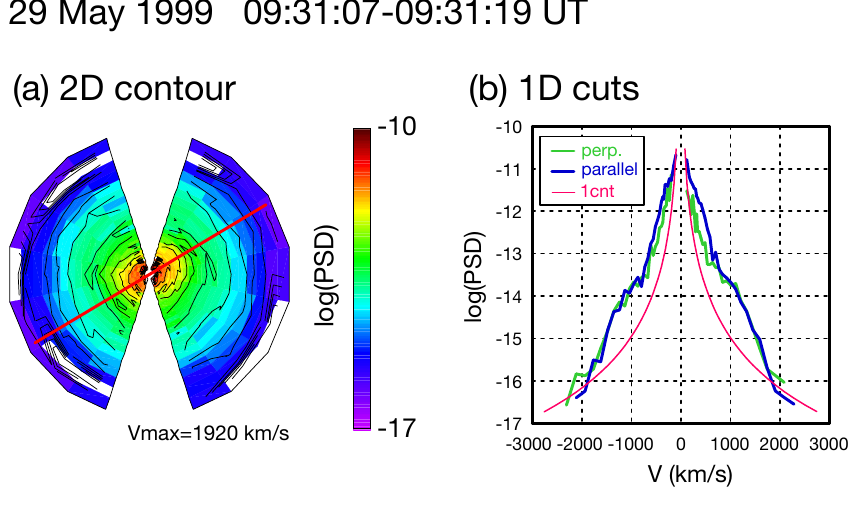
Fig. 6. Cuts of ion phase space density (PSD) for the 12-s interval between 09:31:07–09:31:19UT on 29 May 1999. The left panel (a) shows the contour of the PSD in the plane that includes the local magnetic field which is shown as a red bar in the figure. The right panel (b) presents one-dimensional cuts of the ion PSD. The green (blue) line shows the PSD in the direction perpendicular (parallel) to the magnetic field. Two red curves correspond to the one count level of the detector.